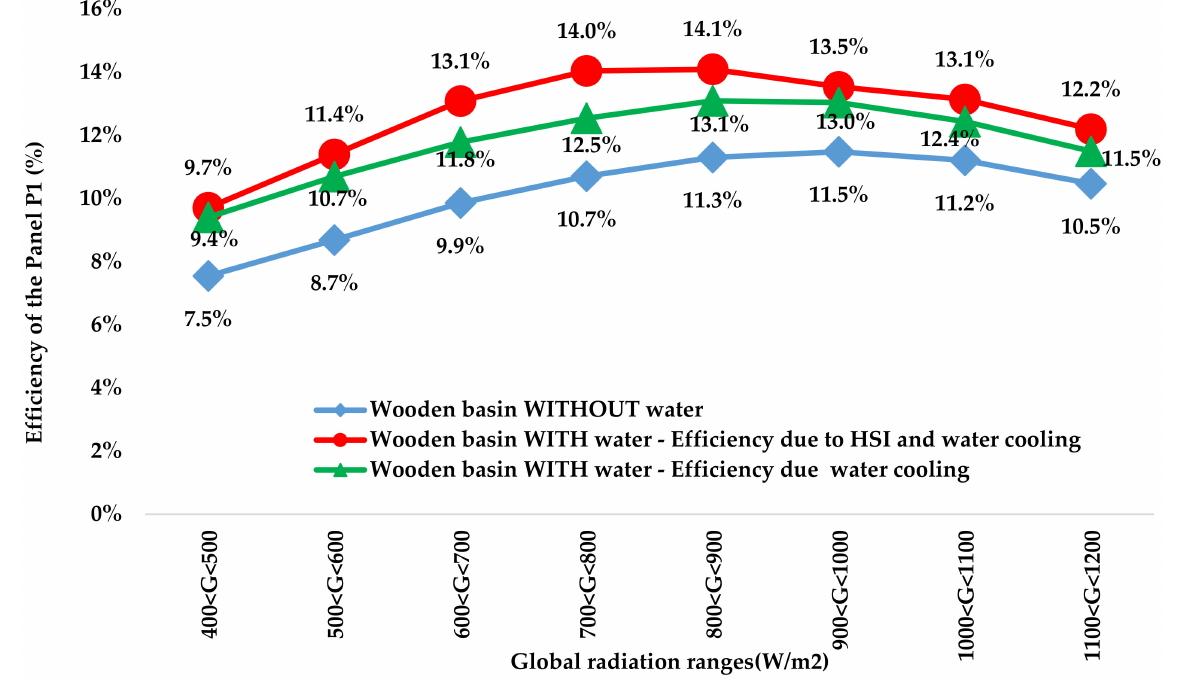
Figure 11. The efficiency increment of the PV panel